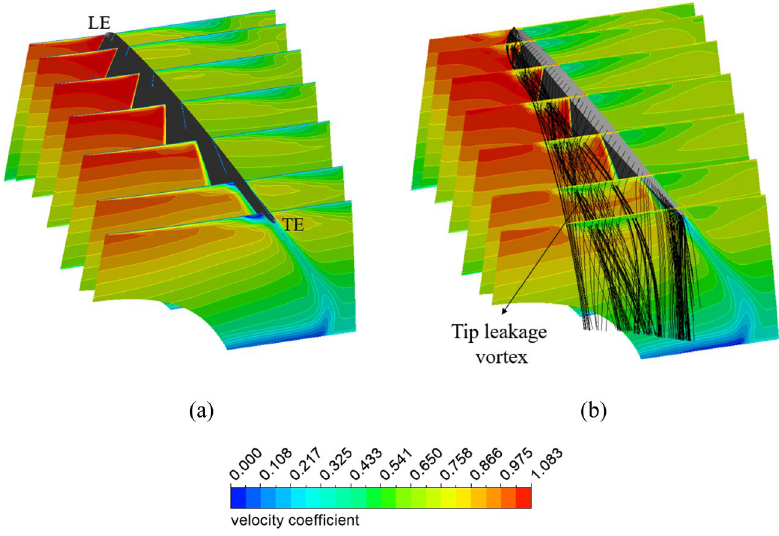
Figure 17. Velocity and streamline distribution in impeller passage. ( a ) Reference case (no gap) and ( b ) impeller’s clearance.